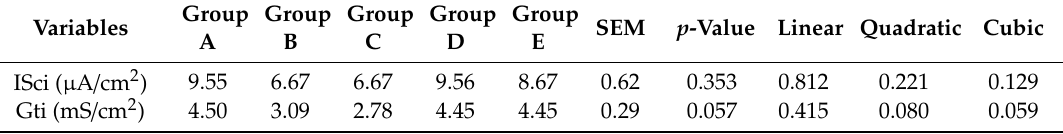
Table 4. Effect of Cr-CNPs supplementation on initial short-circuit current and tissue conductance before the addition of L-glutamine.